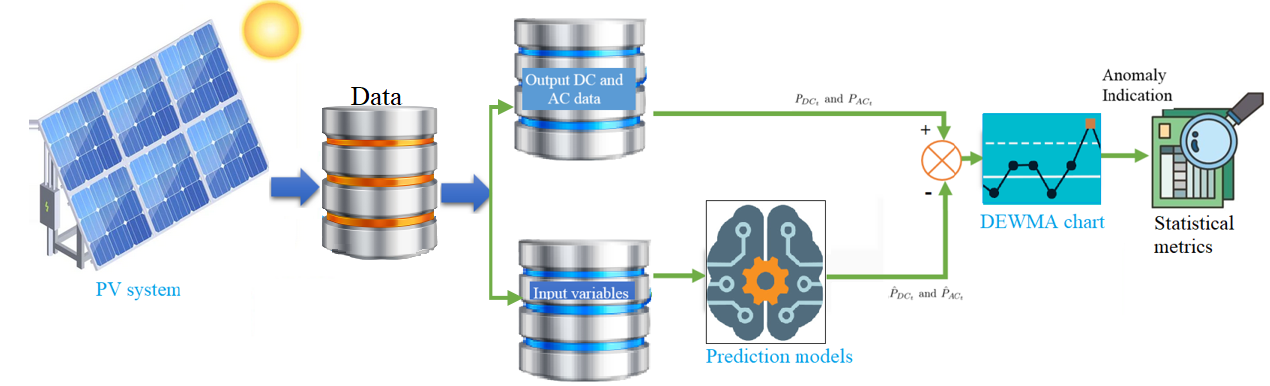
Figure 10. The framework of the proposed ensemble learning-driven fault detection